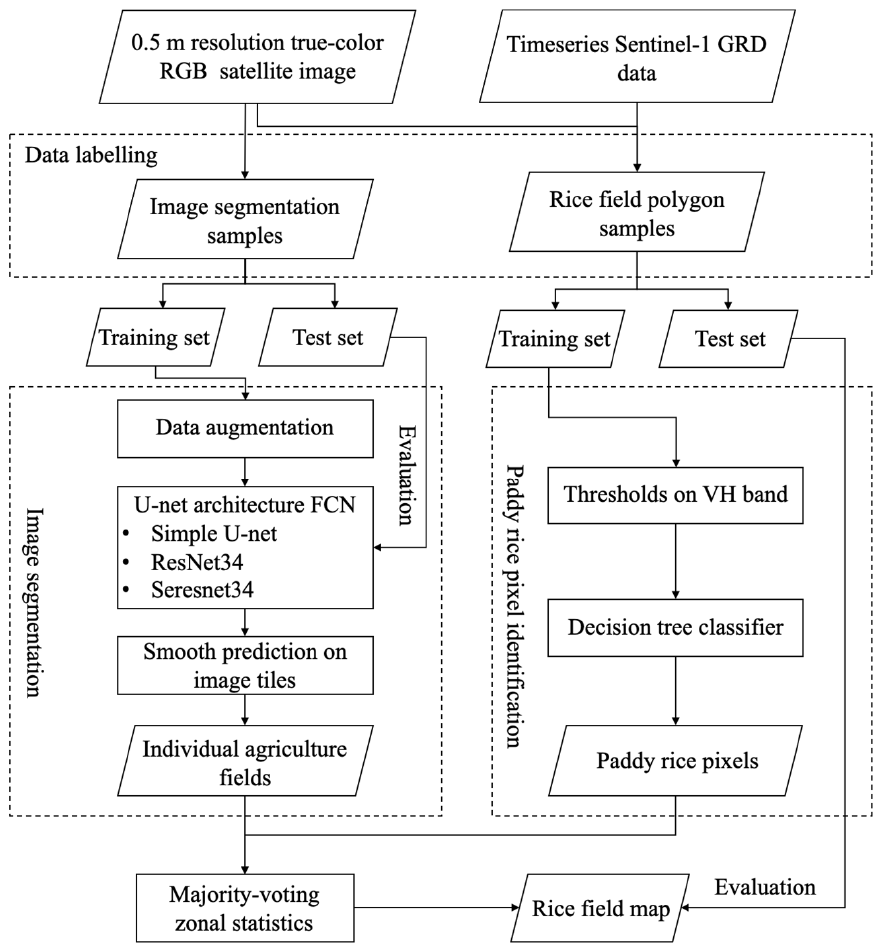
Figure 4. The workflow of the proposed method that combines image segmentation and pixel-based classification for high-resolution rice field classification for high-resolution rice field mapping.